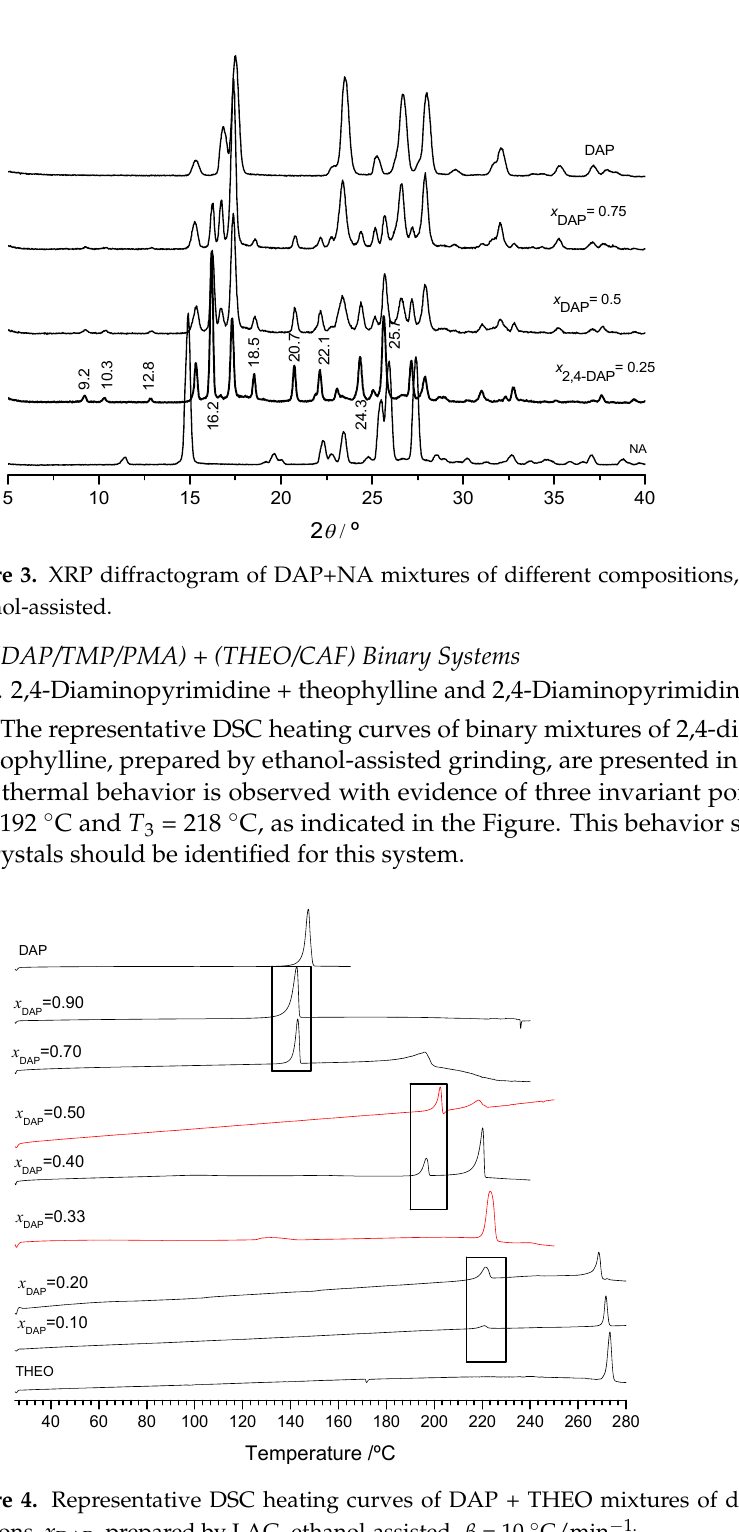
Figure 2. (Solid + liquid) binary phase diagram of DAP + NA; ■ and solid line—experimental soli- dus; ●—experimental liquidus . Dotted lines obtained using eqs. ( 1 ) and ( 2 ).